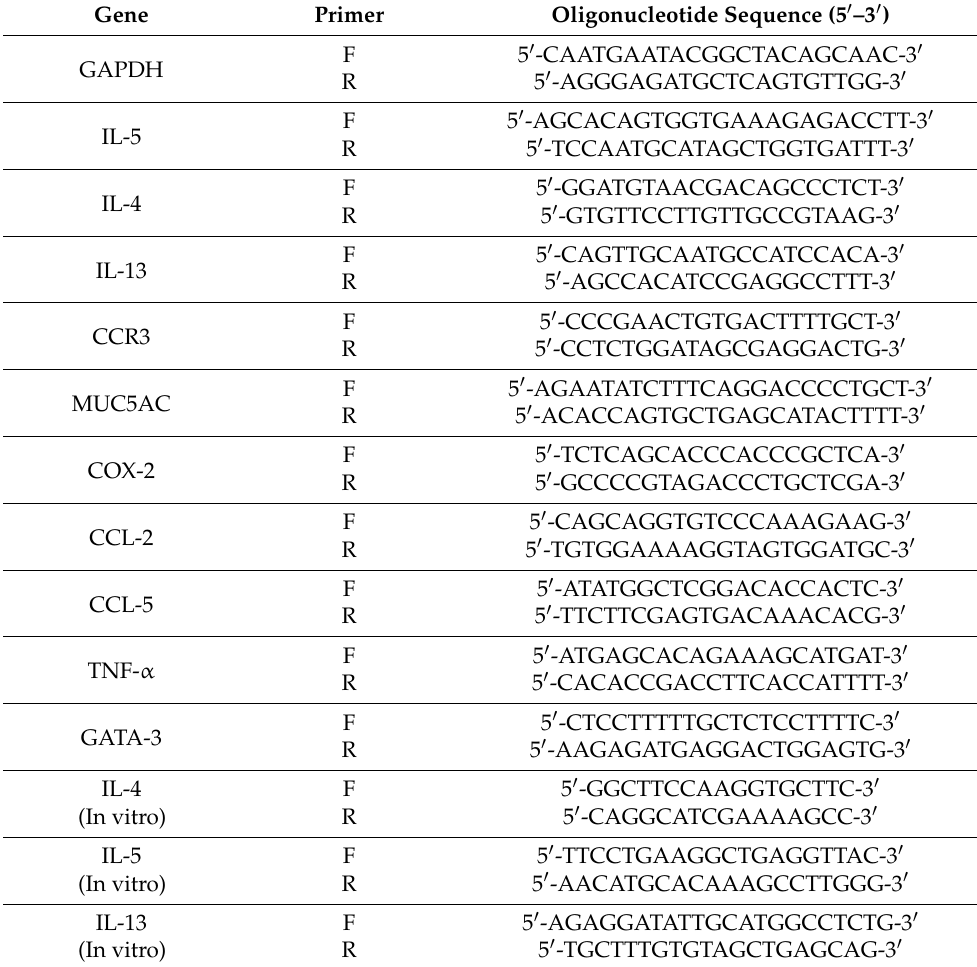
Table 3. Primers and probe sequence used in real-time PCR